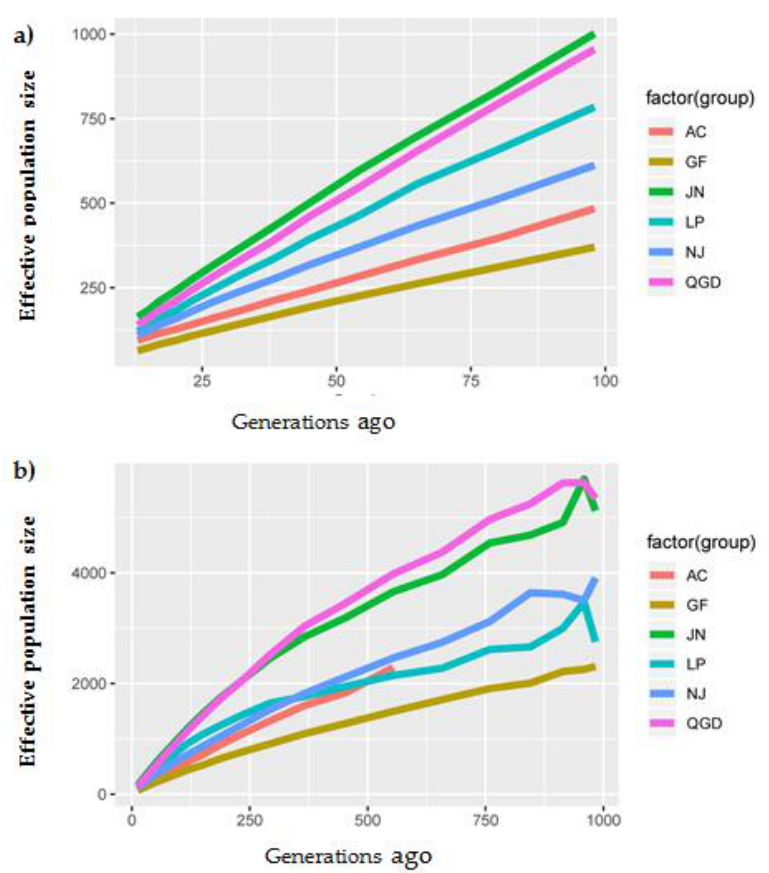
Figure 5. Average estimated effective population sizes in six goat populations. ( a ) Ne in the past 100 generations. ( b ) Ne over the past 1000 generations.